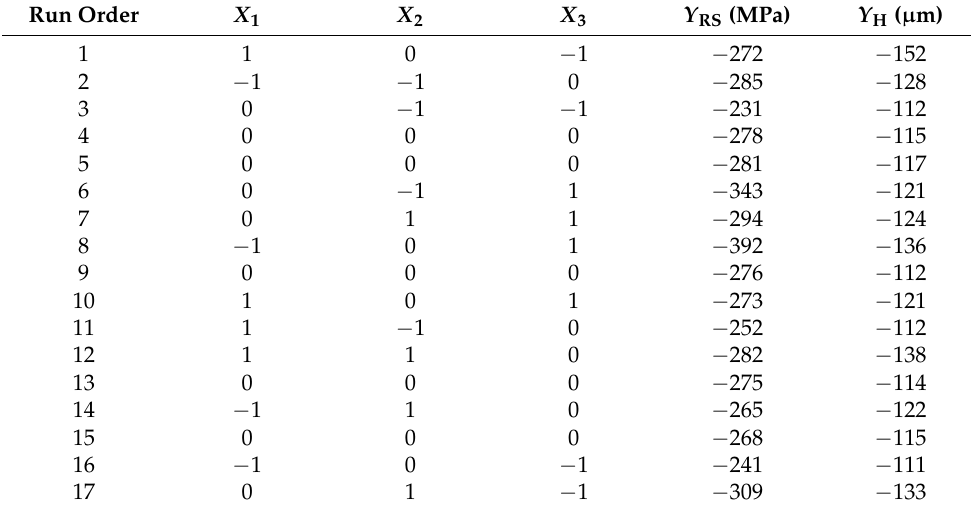
Table 3. Box-Behnken design matrix and